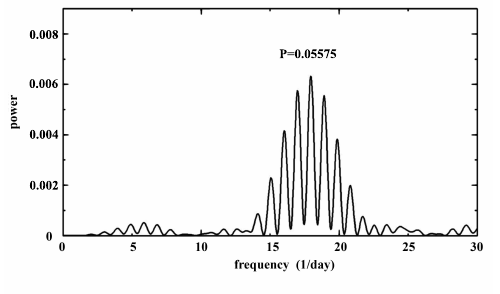
Figure 5: One of the V844 Her power spectra as an example.